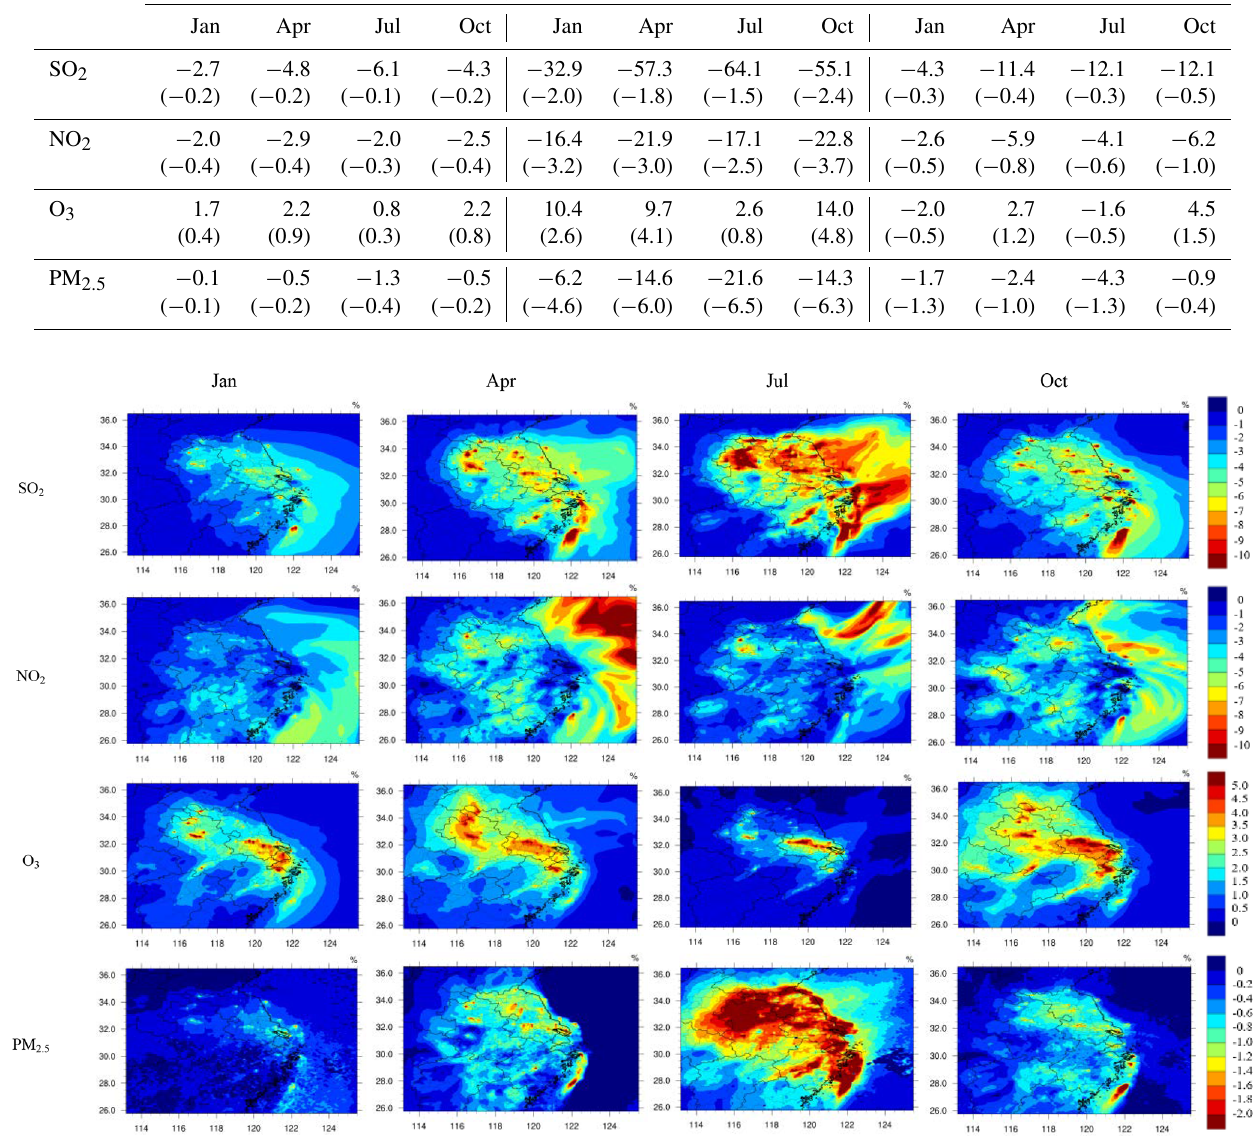
Figure 3. The spatial distributions of the relative changes (%) in the simulated monthly SO 2 , NO 2 , O 3 , and PM 2 . 5 concentrations between cases 2 and 3 in D2 ((case 3 − case 2) / case